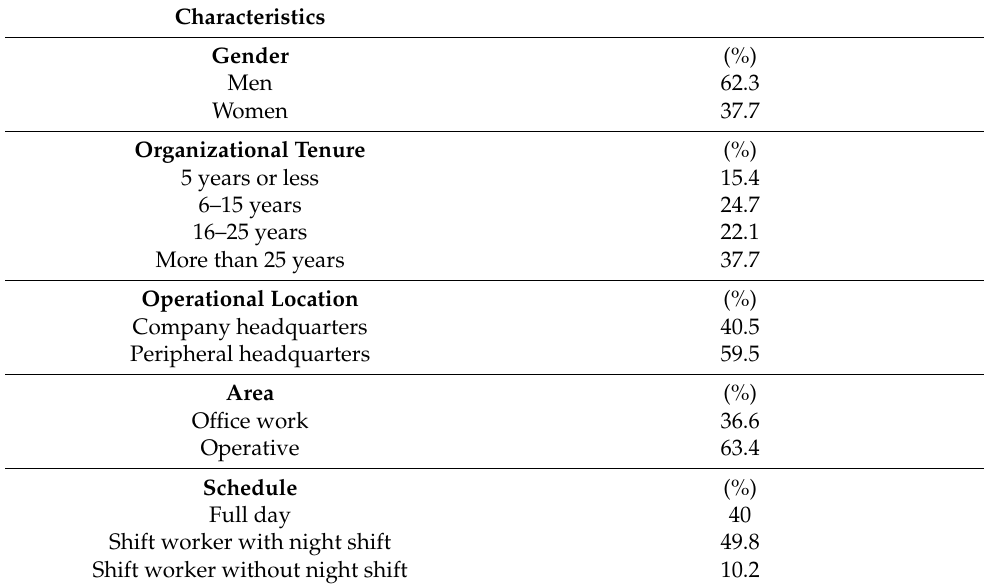
Table 1. Individual characteristics of the sample.